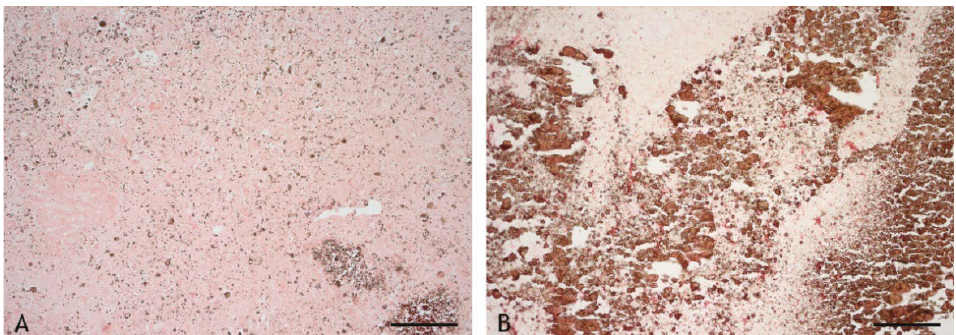
S—solid, coarse; D—dusty, granular; + <10% of necrosis calcified; ++ 10–50% of necrosis calcified; +++ >50% of necrosis calcified; --- no central necrosis.